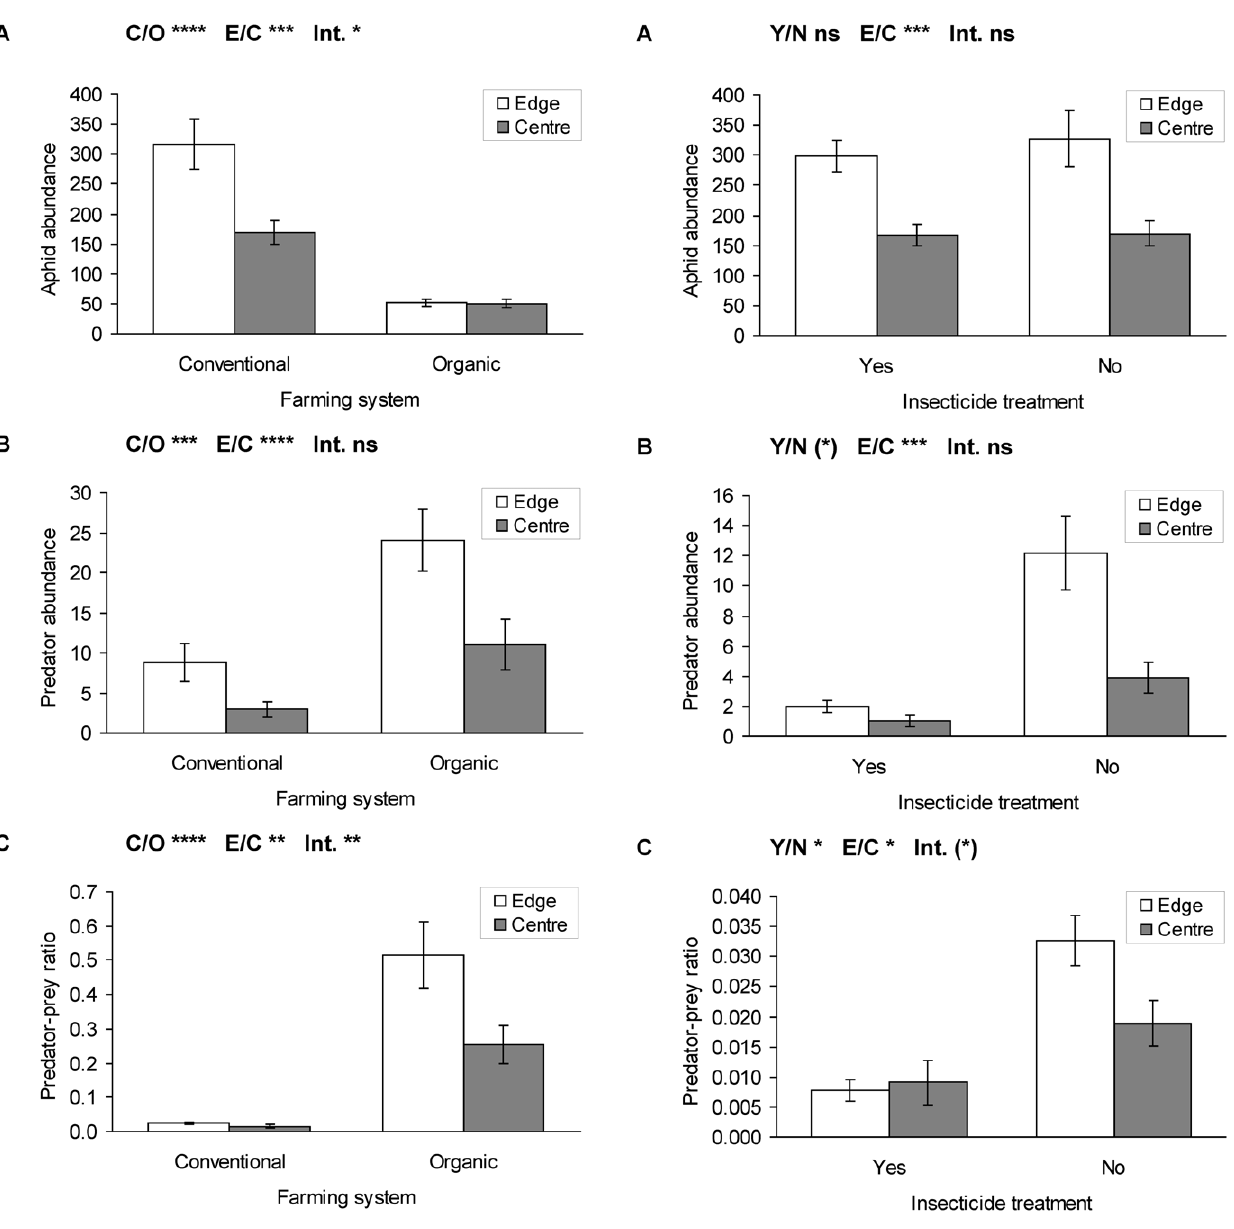
Figure 4. Abundances of (a) aphids, (b) aphid-predators and (c) predator-prey ratio in insecticide treated and non-treated conventional triticale field edges and centres (mean ± se). Y/N: treated/not treated fields, E/C: edge/centre in field, Int: Interaction